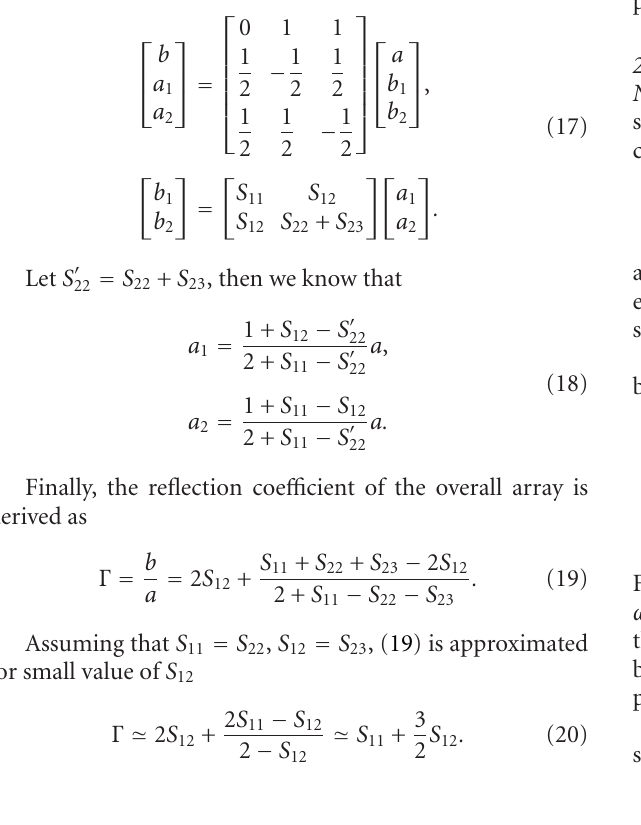
Because a 1 = a 4 , a 2 = a 3 , and b 1 = b 4 , b 2 = b 3 , (15) and (16) are simplified